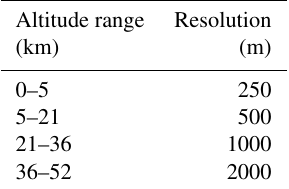
Table 4. Vertical resolution of the Streamer model. Table 5. RTM input parameters for the cloud layer